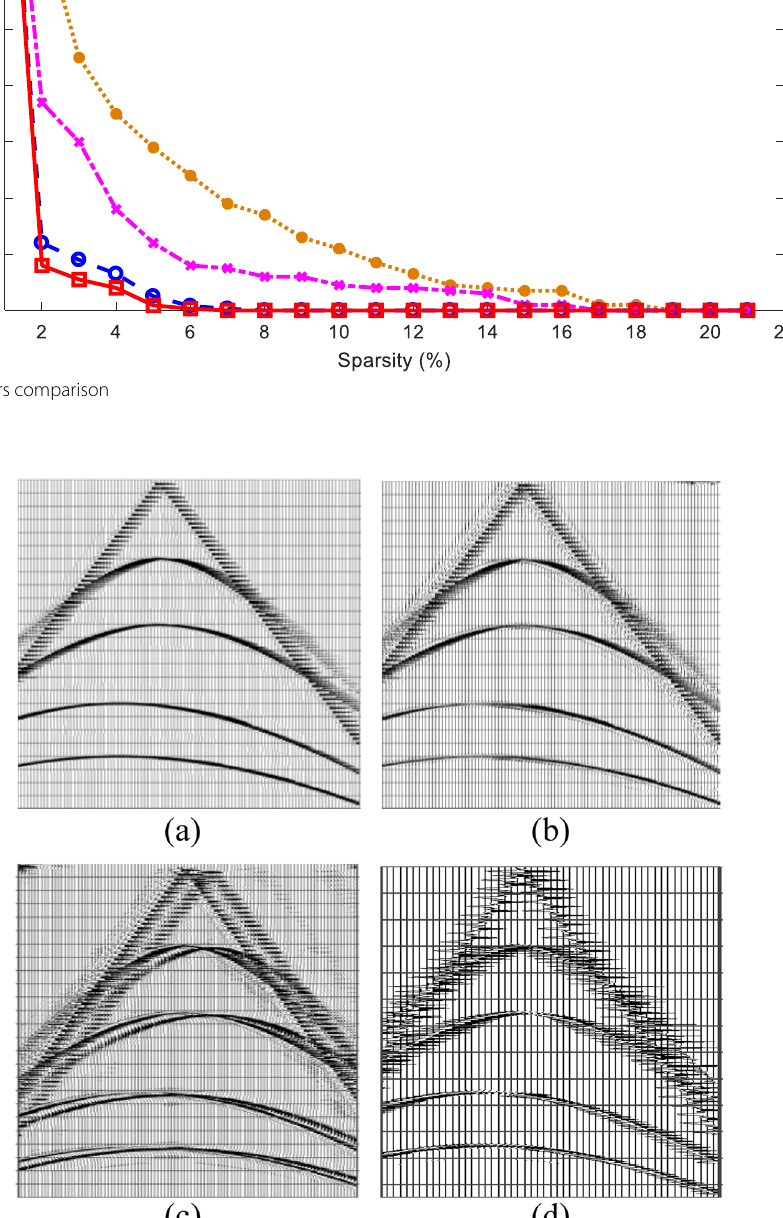
Fig. 4 Comparison of CSST, NSST and WT coefficients on the synthetic seismic data: ( a ) The original synthetic seismic data; the fusion of HF coefficients of ( b ) CSST, ( c ) discrete NSST, and ( d )